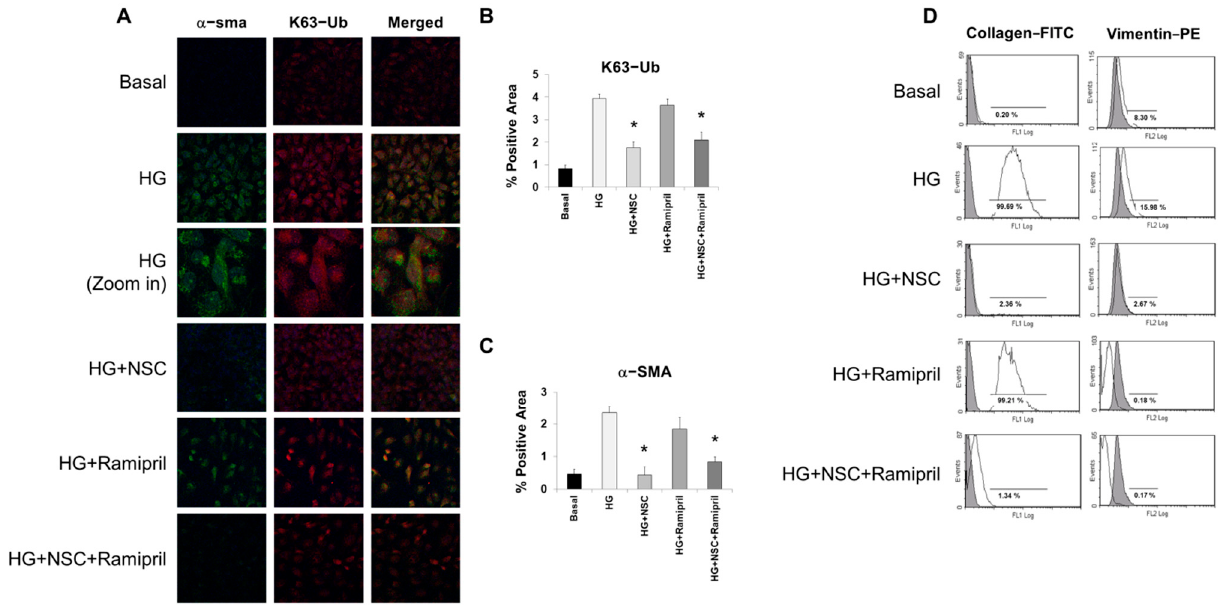
Figure 1. NSC697923, alone and in combination with ramipril, but not ramipril alone, reduced EMT in tubular cells. ( A ) Immunofluorescence (IF) depicting α -sma expression (green channel), K63 ubiquitinated proteins distributions (red channel), and the merged signal in HK2 cells under the indicated treatments. Figure magnification 63X. ( B , C ) IF quantification for K63-Ub ( B ) and α -sma ( C ). Expression was quantified as the percentage of positive area. * p < 0.0001 vs. HG. ( D ) Flow cytometry analysis on collagen I and vimentin. % of positive cells in the different experimental conditions is indicated in the figure panels. Results are representative of three independent experiments.